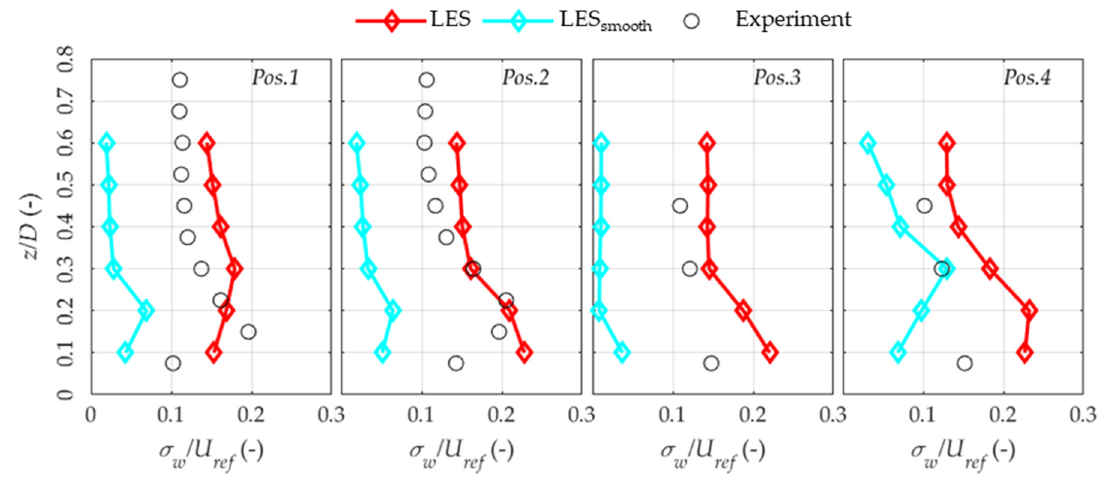
Figure 10. Vertical turbulence intensity for position 1 and position 2.